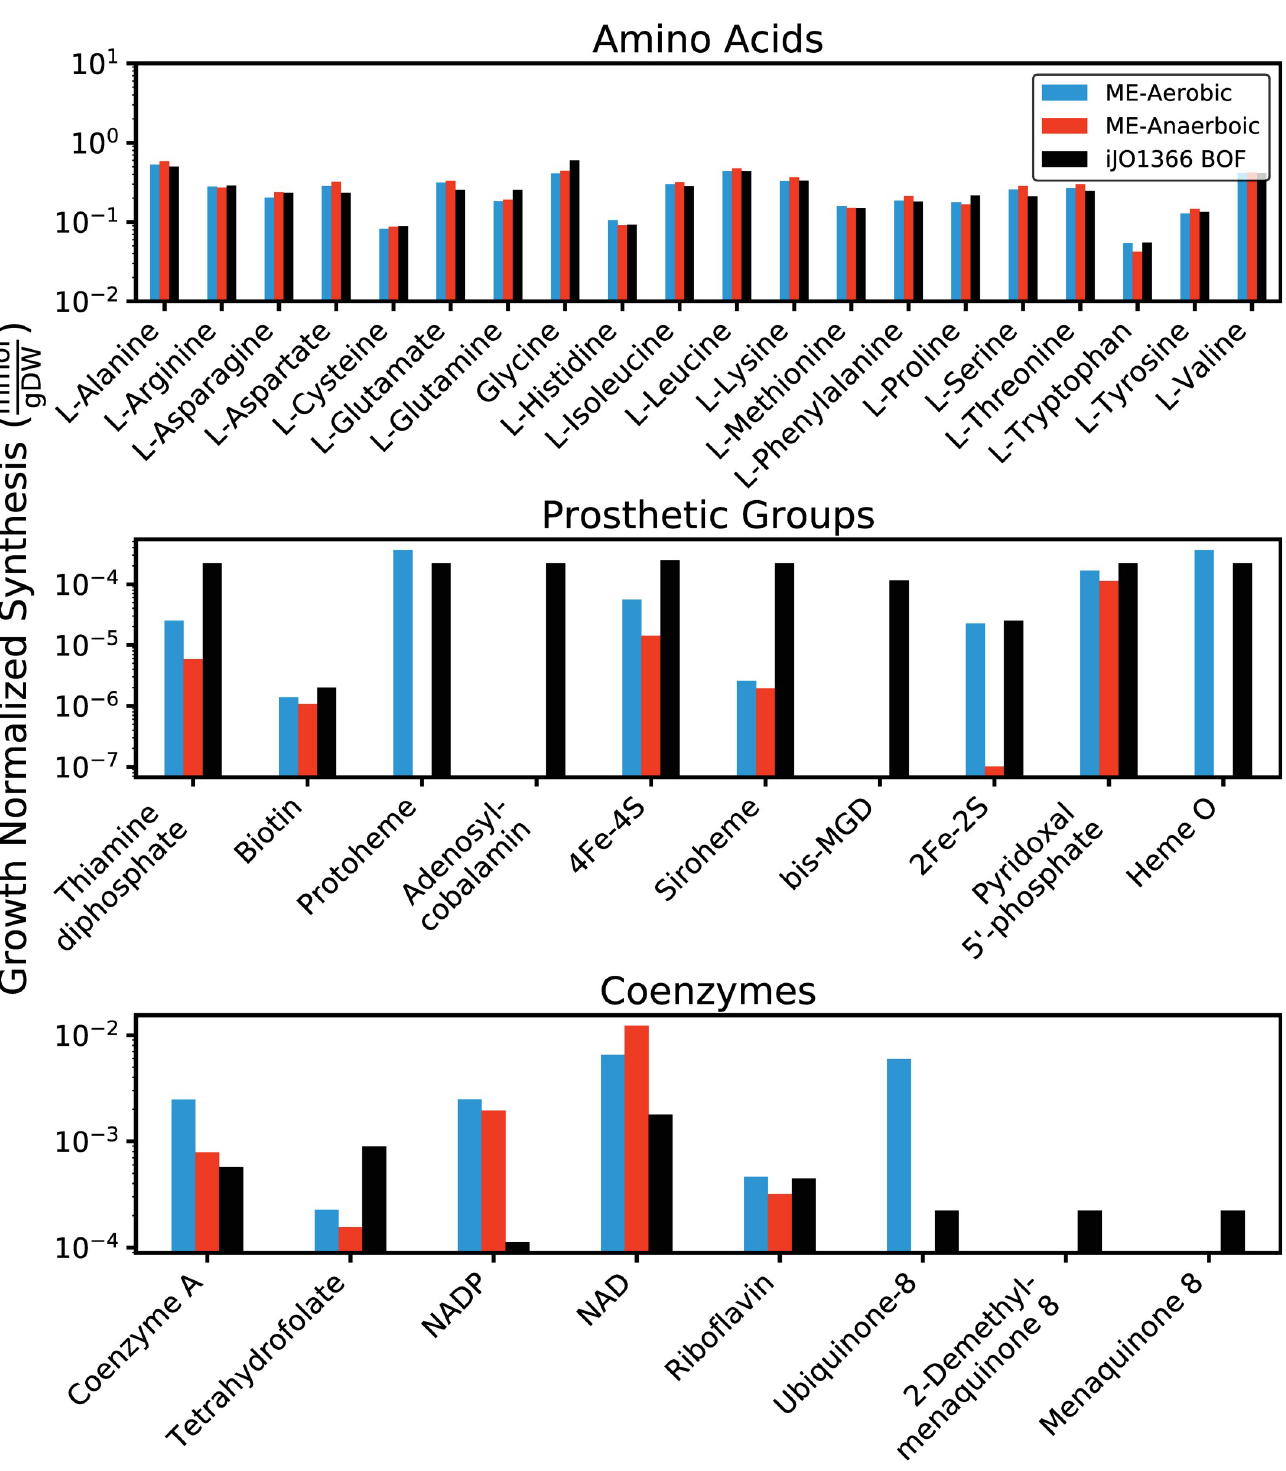
Fig 2. Comparison of growth-normalized ME- and M-model computed amino acid and cofactor synthesize rates. The ME-model biomass synthesis demands are a function of the predicted intracellular fluxes provided by the simulation, whereas the M-model values are provided by the biomass objective function. ME- model predictions are shown for aerobic and anaerobic in silico